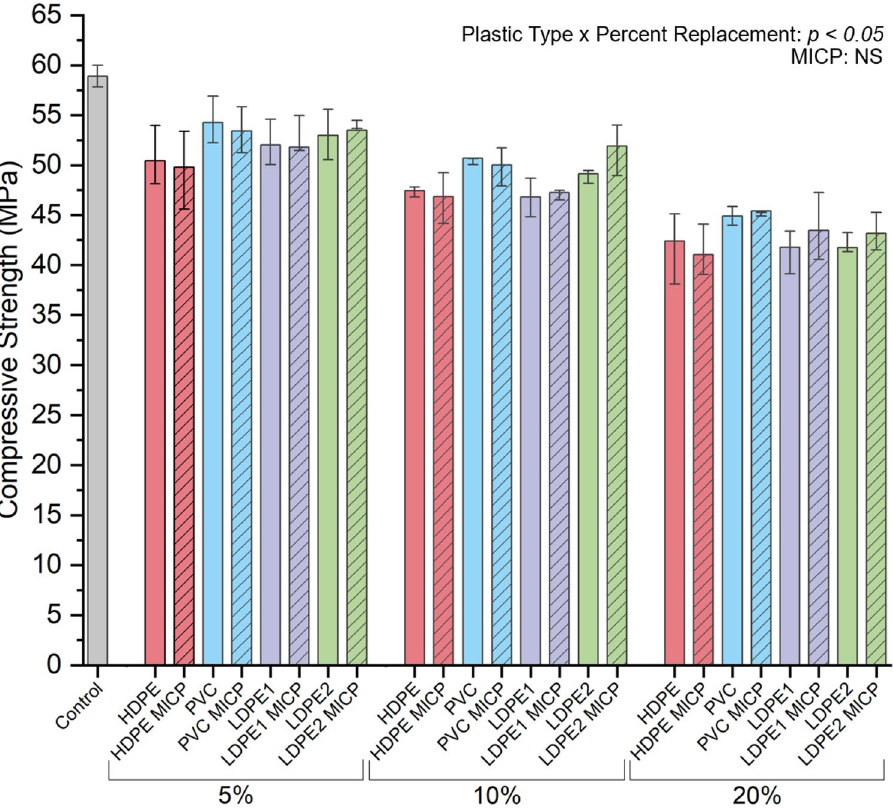
Figure 5. Compressive strengths at replacement percentages 5–20% with waste plastic and no treatment (solid) and MICP-treated waste plastic (striped). Each color indicates a different type of waste plastic: HDPE (red), PVC (blue), LDPE1 (purple), and LDPE2 (green). The bar heights represent the mean, and the error bars indicate one standard deviation.